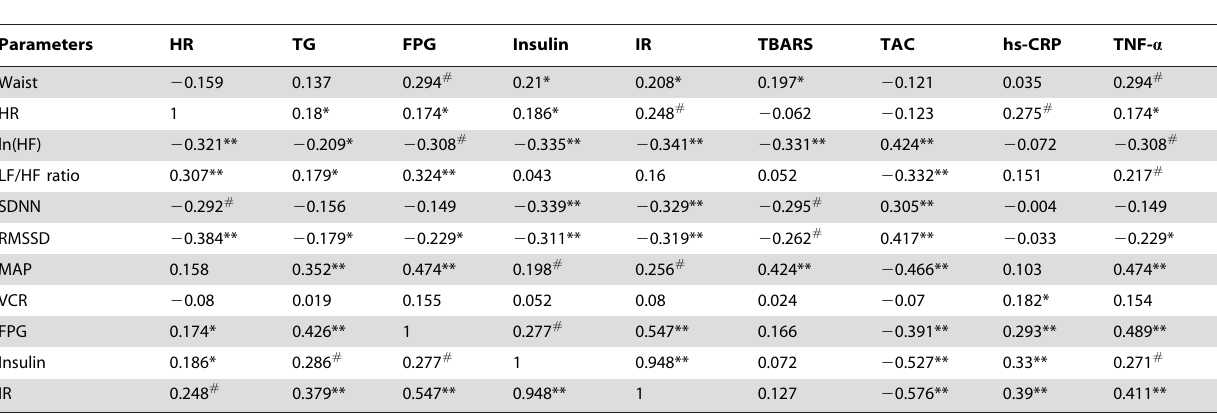
Table 6. Spearman correlation (‘r’ value) of resting physiological, cardiac autonomic functions with biochemical parameters.